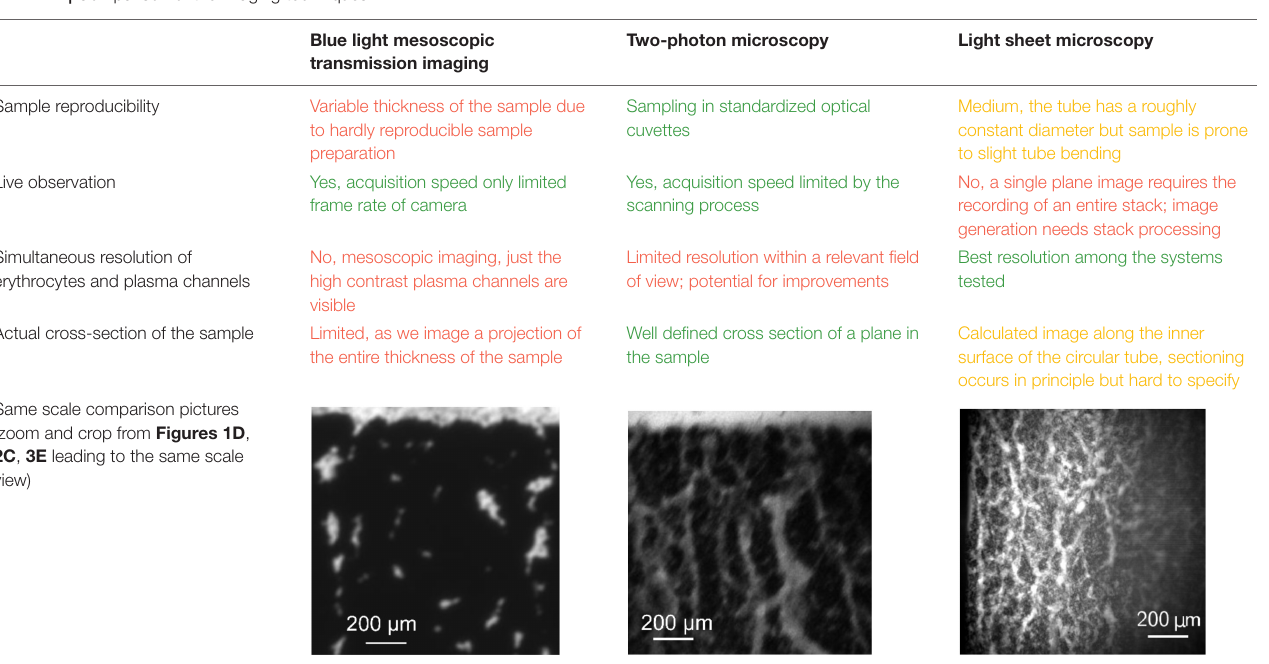
TABLE 1 | Comparison of the imaging